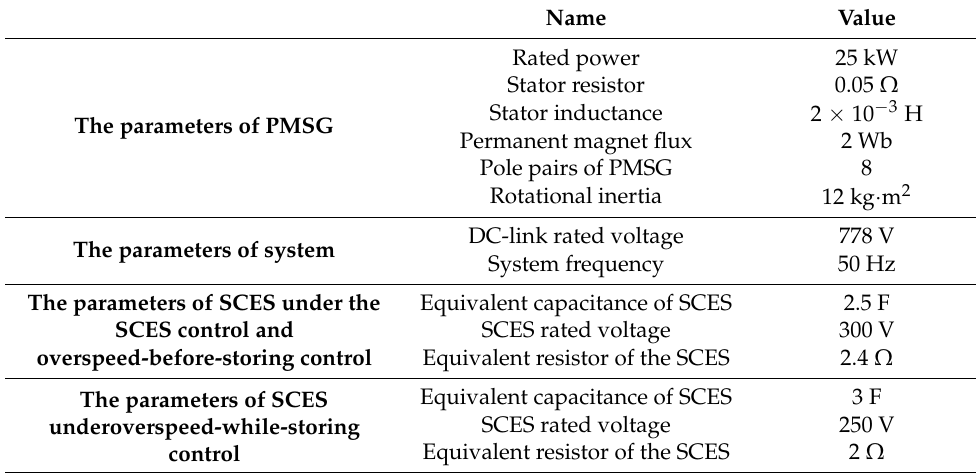
Figure 10. The simplified modeling of the grid-connected wind system. Table 1. Simulation parameters of the wind